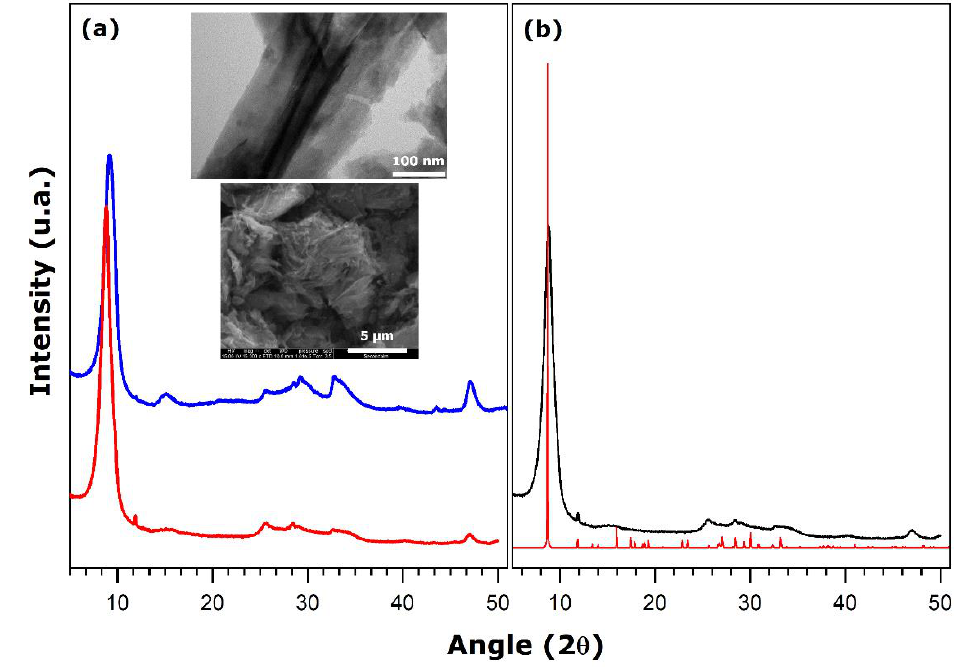
Figure 6. Wide-angle XRD patterns recorded on hybrid hexadecylamine-vanadium oxide samples exchanged with ammonium cation: ( a ) after the first ( blue line ) and the second ( red line ) exchange step, ( b ) simulated diffractogram ( red line ) generated for the theoretical vanadium oxide structure modified to take into account the real stoichiometry and containing exclusively NH 4+ cations in the interlayer space in comparison with the experimental one ( black line ) after the third exchange step. The inset shows TEM (upper image) and SEM (lower image) micrographs of the sample after one exchange.